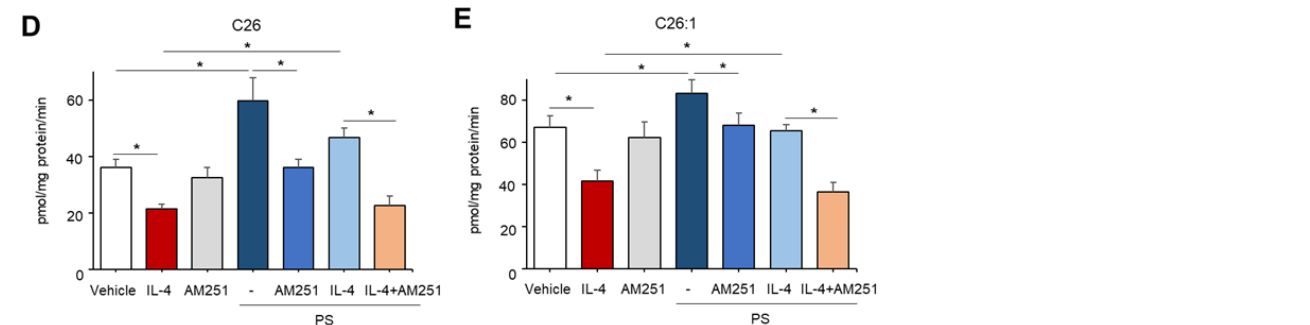
Figure 6. N-palmitoyl serinol (PS) particularly stimulates production of ceramides with long-chain fatty acids (FA) through a CB1-dependent mechanism. HaCaT KC were pretreated with IL-4 (50 ng/mL) for 20 h, followed by incubation with exogenous PS (25 µ M) with or without CB1 inhibitor (AM-251, 10 µ M) for 4 h. Ceramides with different carbon lengths (C22–C26, ( A – E ), respectively) were assessed by the LC-MS/MS system. Statistical significance was calculated using the unpaired Student’s t -test, and significance was defined as * p < 0.01 vs. vehicle control (or untreated control).